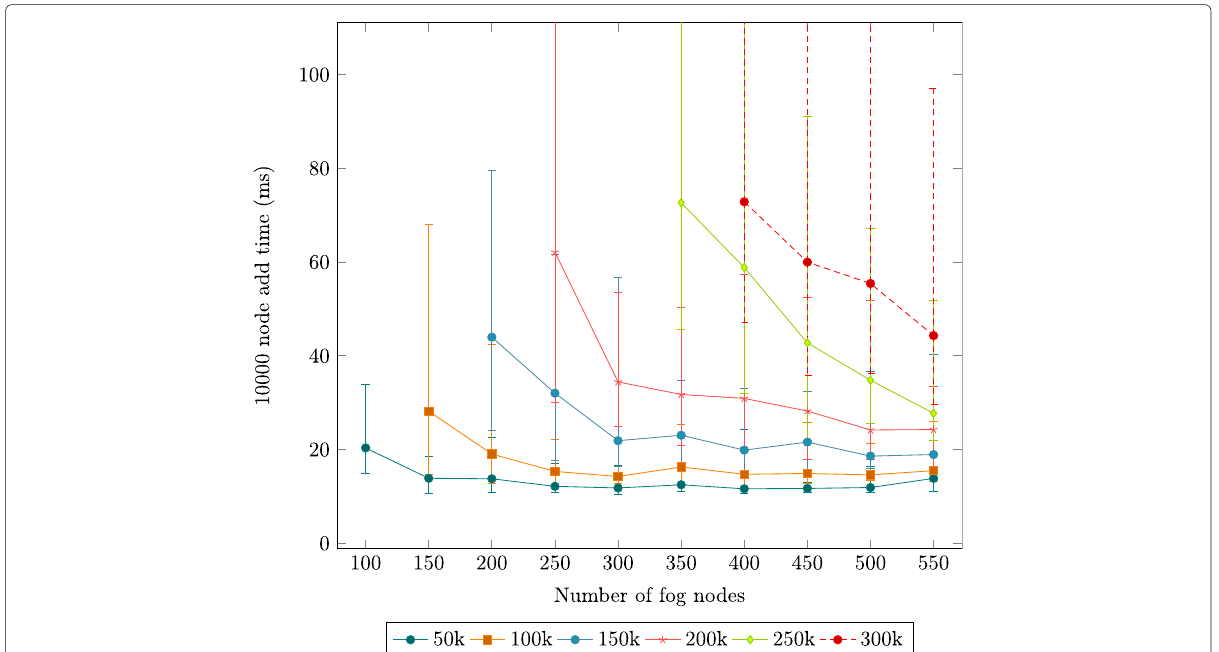
Fig. 4 Time required to add 10000 edge nodes to service topologies of varying sizes. Legend numbers represent thousands of edge